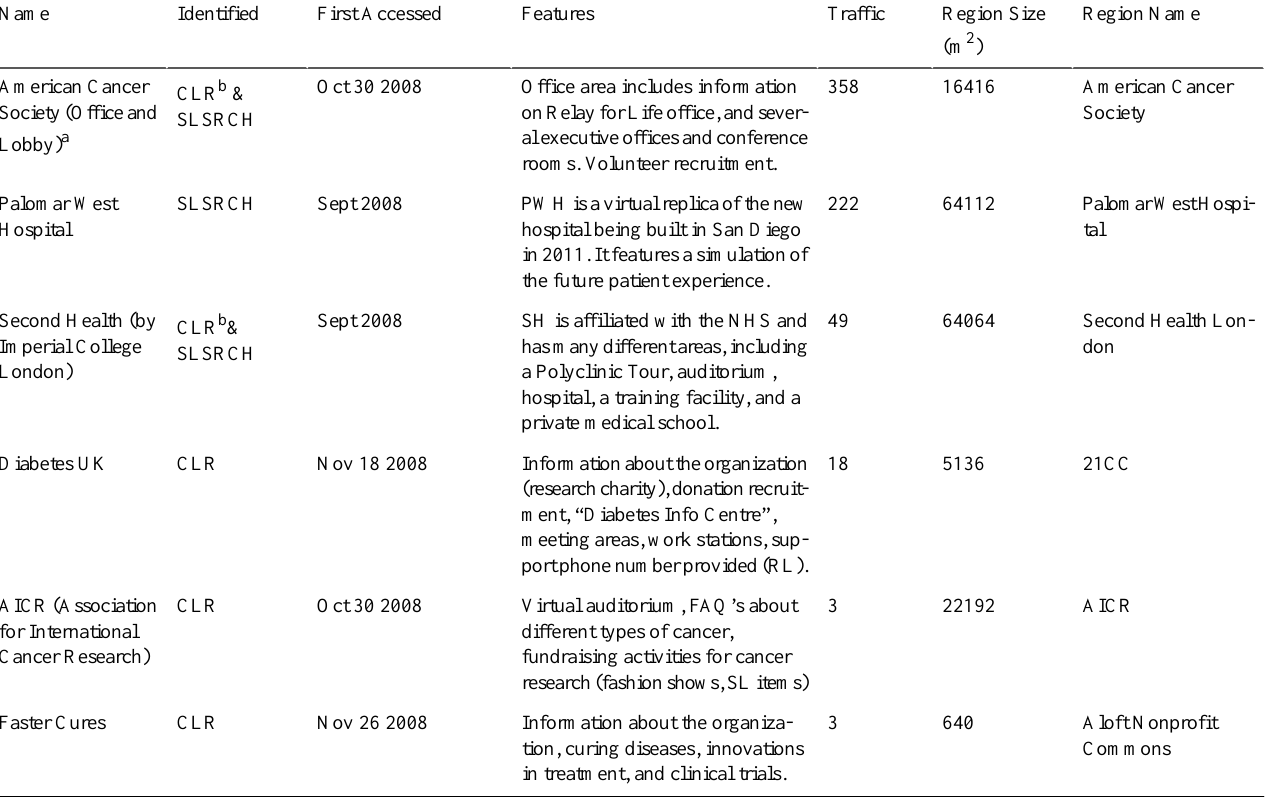
Table 5. Marketing sites (ranked by